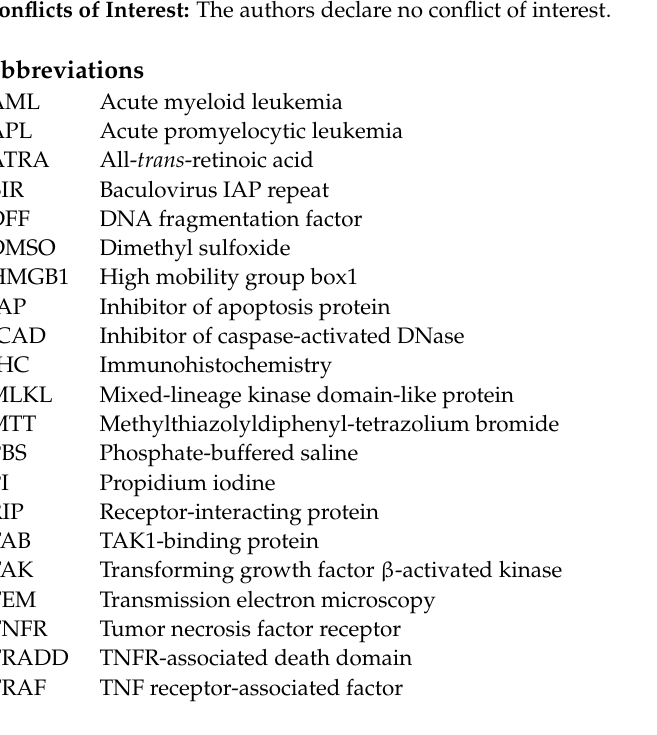
cells, Figure S2: Functional annotation analysis from protein array analysis in ardisianone-treated cells, Figure S3: Effect of ardisianone on DNA damage signals, Figure S4: Effect of ardisianone on cell